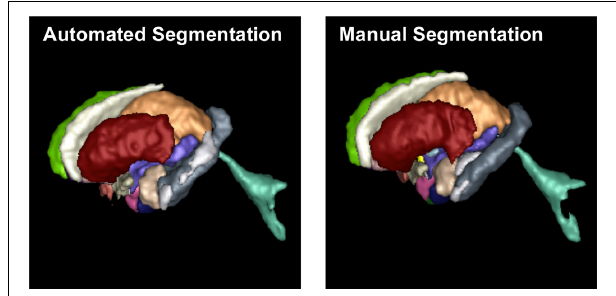
FIGURE 5 | Visual comparison between structures segmented by AutoSeg (left) and the corresponding manually segmented structures (right) via 3D